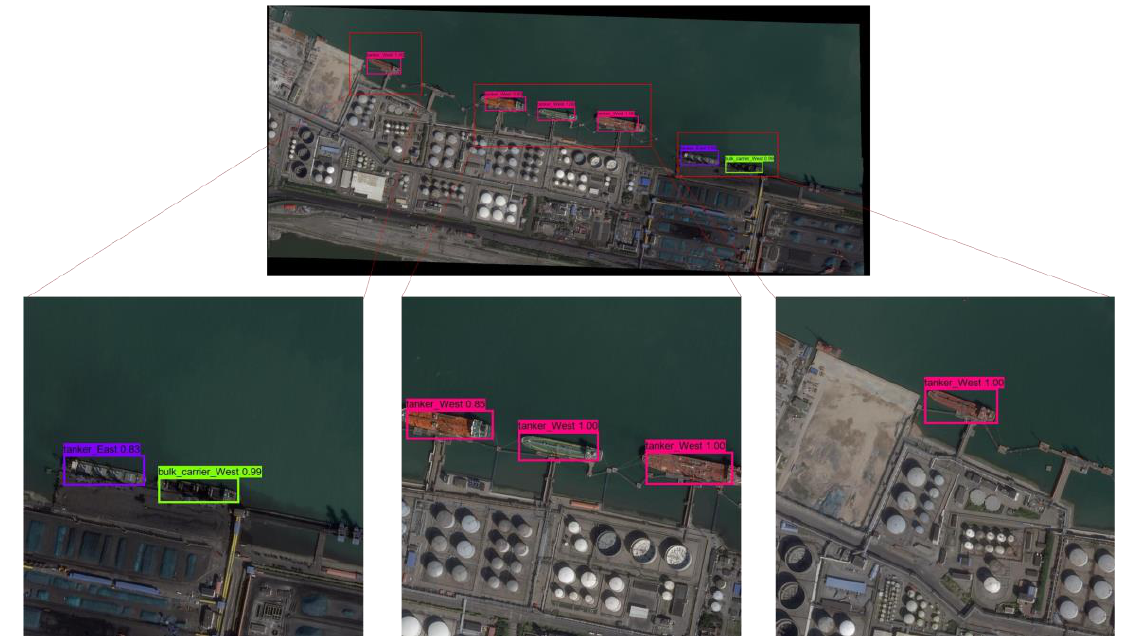
Figure 11. The Skysat image of Tianjin Port.